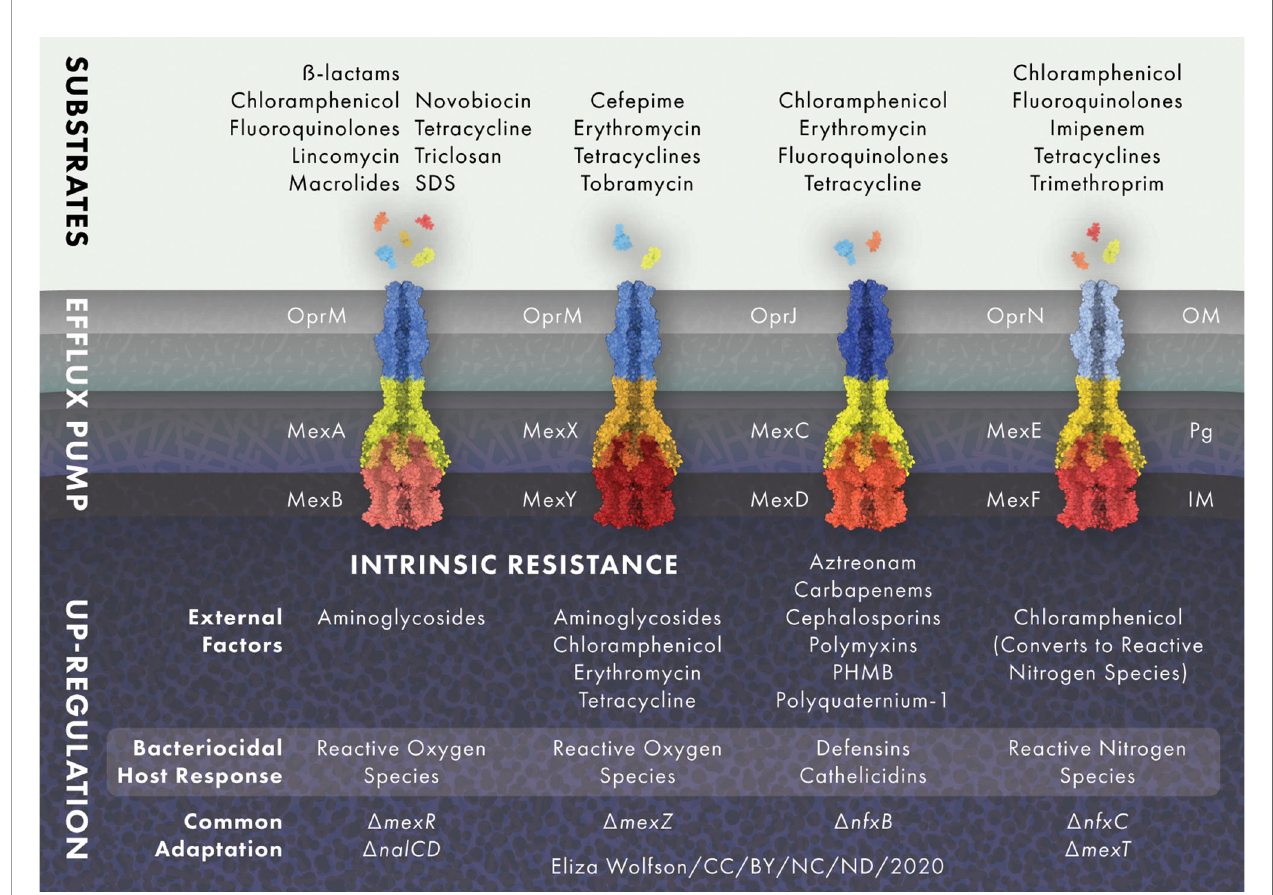
FIGURE 2 | RND ef fl ux pump expression is modulated in response to external stress. MexAB-OprM and MexXY-OprM are positively regulated by reactive oxygen species (ROS) and MexEF-OprN is induced by reactive nitrogen species (NOS), whilst MexCD-OprJ responds to membrane damaging agents and MexXY-OprM to ribosome blocking substances such as chloramphenicol, erythromycin, tetracycline and aminoglycoside antibiotics. Common adaptations leading to up-regulation of ef fl ux pumps include; loss of active transcriptional regulators mexR, nalC and nalD for MexAB-OprM, loss of the transcriptional repressor mexZ for MexXY-OprM, loss of transcriptional regulator nfxB for the MexCD-OprJ ef fl ux system and nfxC type mutations and/or loss of active transcriptional activator mexT for MexEF-OprN. Protein and drug structures were generated with Protein Imager (Tomasello et al.,